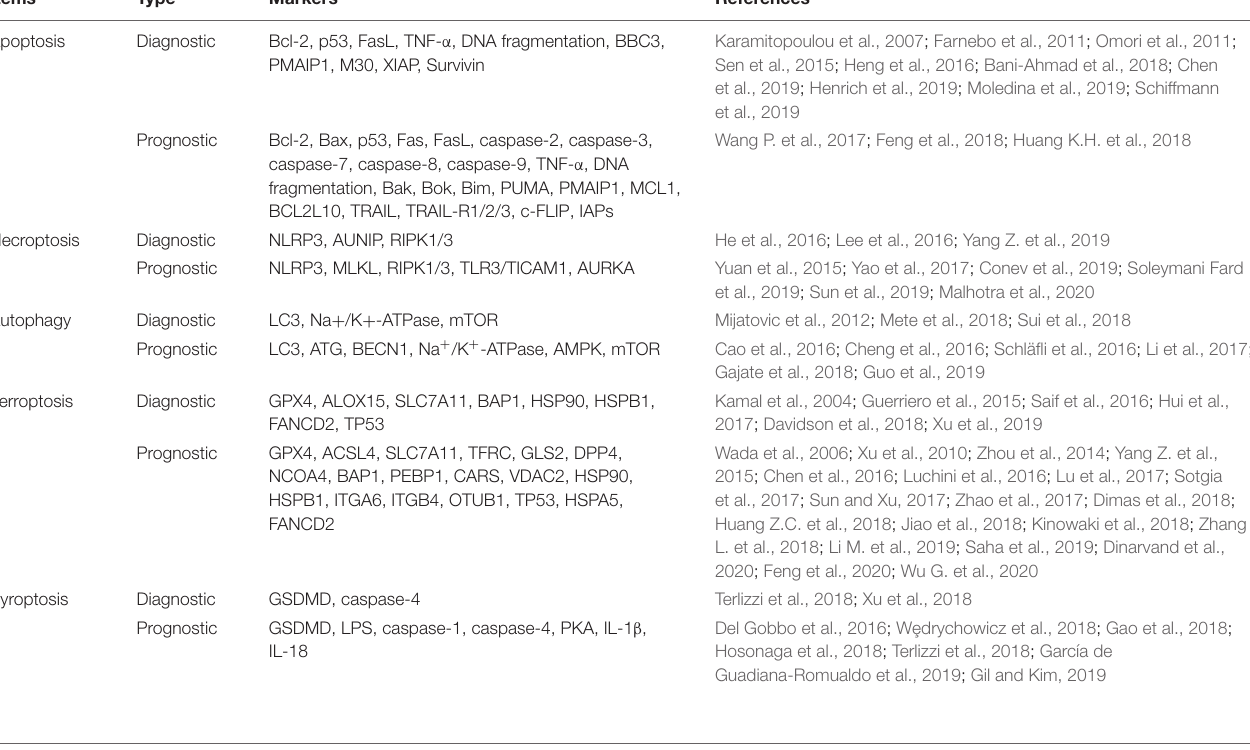
TABLE 4 | Biomarkers of RCDs used in diagnostic, prognostic and research histopathology.